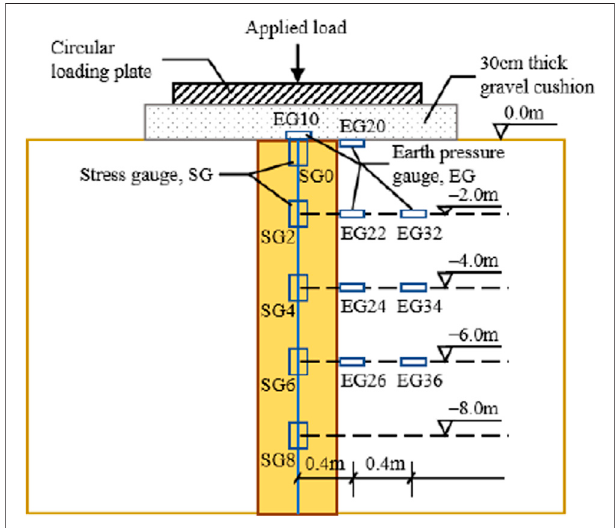
FIGURE 1 | Schematic diagram of the arrangement of stress gauges and earth pressure gauges.